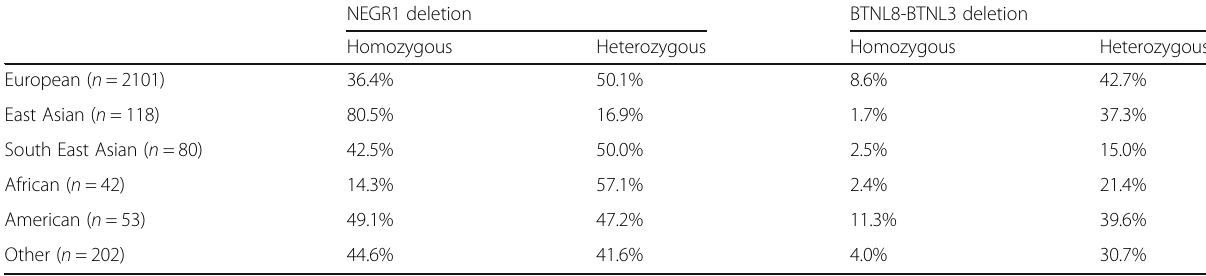
Table 2 NEGR1 and BTNL8-BTNL3 deletions in population